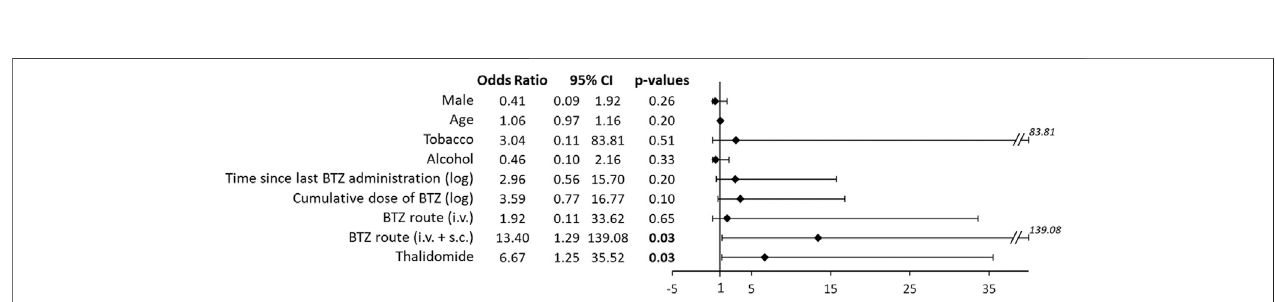
FIGURE4| Forrestplotoftheregressioncoef fi cientscomparingsensoryCIPNwithpatientcharacteristics andtreatments.Multivariableanalyseswereperformed, includingpatientcharacteristics:gender(malevs.female),age,tobacco,andalcohol;andchemotherapycharacteristics:timesincelastbortezomib(BTZ)administration (logarithmictransformation),BTZcumulativedose(logarithmictransformation),routeofBTZadministration(intravenous(i.v.)vs.subcutaneous(s.c.)andi.v.+ s .c.vs.s. c.), and thalidomide administration. Statistical analysis was performed using multivariable logistic regression.